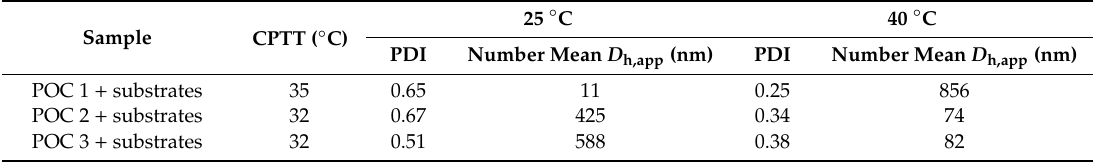
Figure 6. Development of the number mean apparent hydrodynamic diameter ( D h,app ) and polydispersity index (PDI) as a function of solution temperature for ( a ) POC 1, ( b ) POC 2, and ( c ) POC 3 thermoresponsive block copolymers carrying the immobilized organocatalyst in aqueous media containing the substrates p -NBA and CH (dot = number mean hydrodynamic diameter, square = PDI). Table 4. Characteristic parameters for the temperature-induced aggregation of the thermoresponsive block copolymers carrying the immobilized organocatalyst in aqueous media containing the substrates p -NBA and